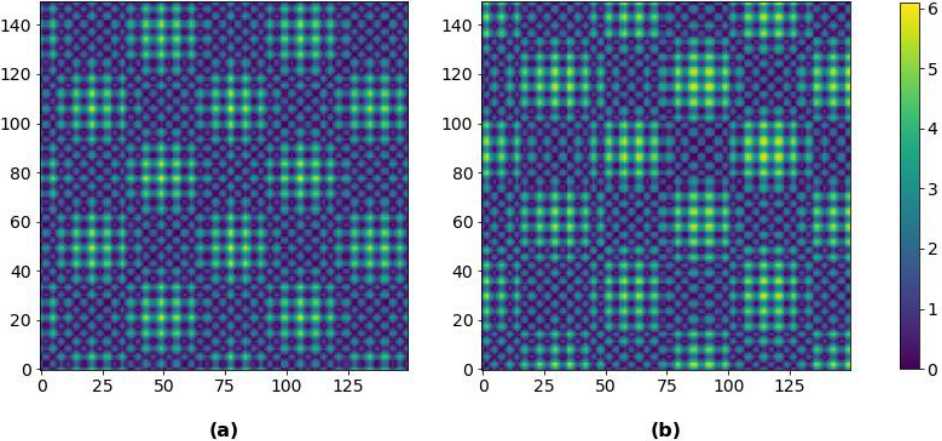
Figure 14. Distance plots for training the CNN in Method II, with a window length of 150 time steps: ( a ) original time series; and ( b ) surrogate time series. Table 3. CNN training parameters during contrast-based learning for Method II.